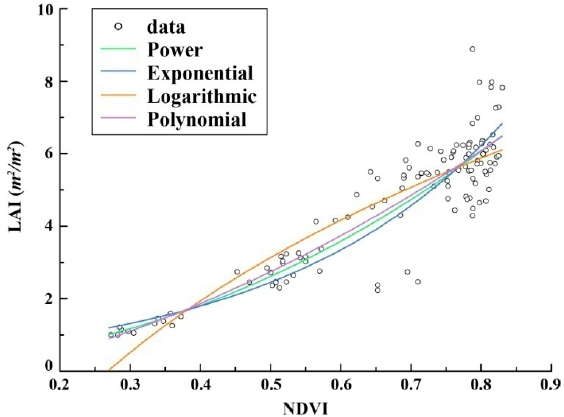
Figure 3. Relationships between field-measured NDVI and LAI as represented by four fitting functions. Table 1. Statistical estimation models of LAI.